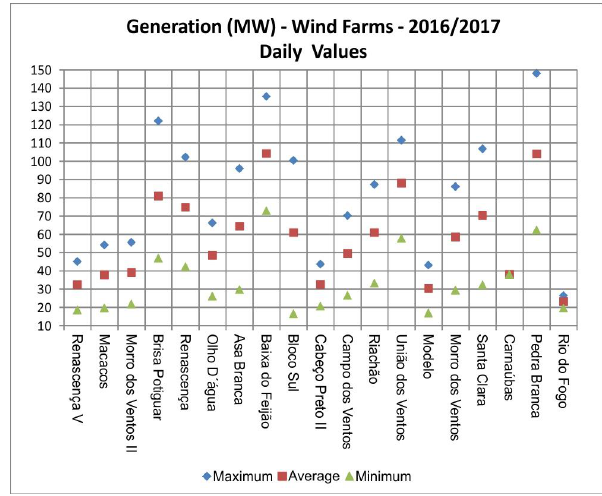
Figure 3. Maximum, average, and minimum daily values of active power (MW) wind farms.